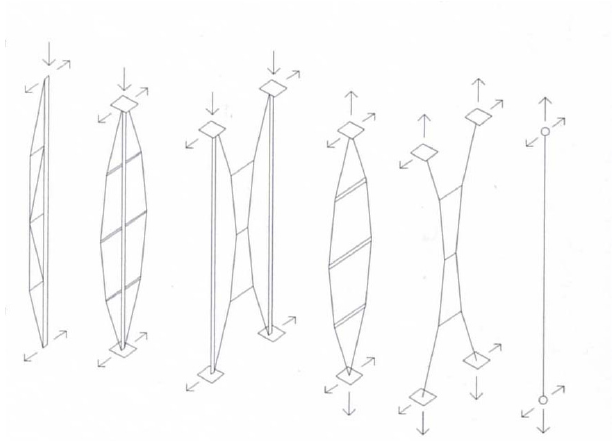
Figure 1: Principle primary structural systems of cable-stayed façades